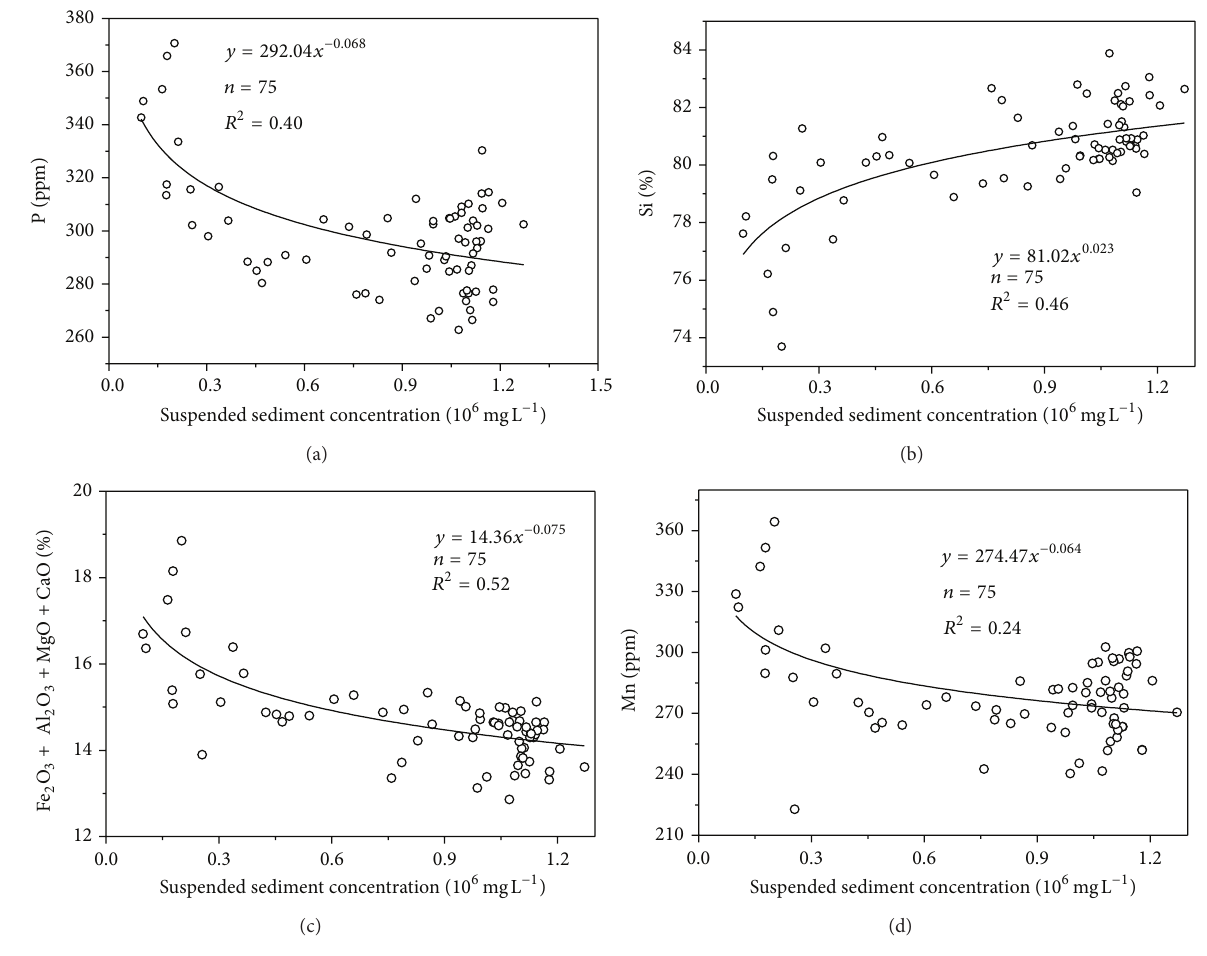
Figure 9: Relationships between suspended sediment concentration and some element contents.